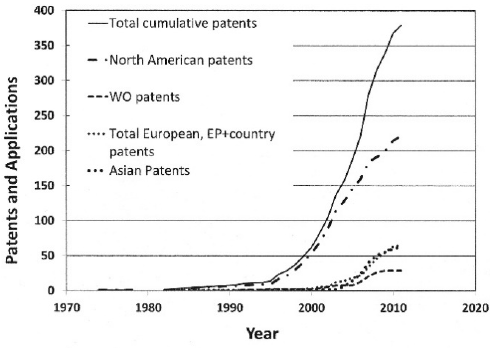
Figure 19. Growth of the number of patents associated with laser shock peening (LSP).